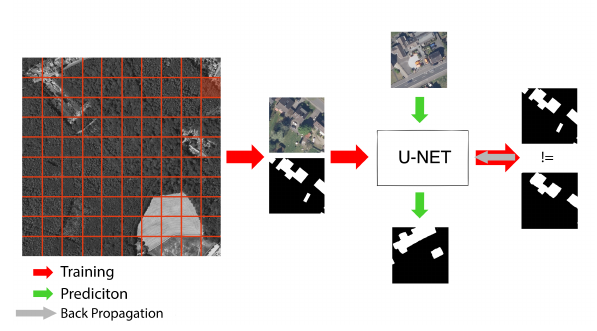
Figure 1. After splitting up the initial true-orthophoto into tiles, the training images and labels (black and white binary images) are being used to train the U-Net. While red arrows show the path to train the U-Net, the green arrows show the path to predict (to the network) unknown images. The gray arrow (back propagation) is supposed to depict that there is a training process